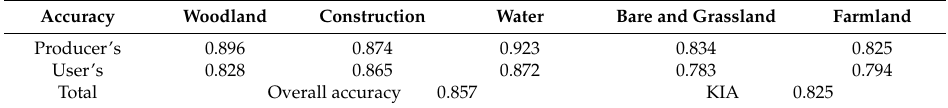
Table 1. Assessment accuracy of land cover types map of Ningdu County using object-oriented method.